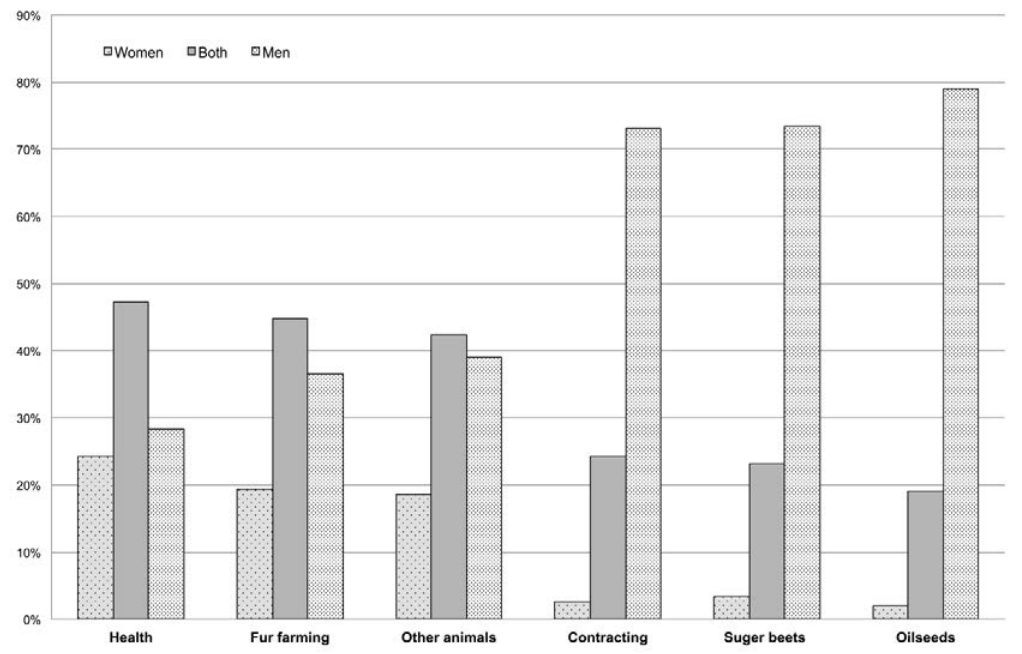
Figure 1. The three business activities with the highest representation of women and men as operations